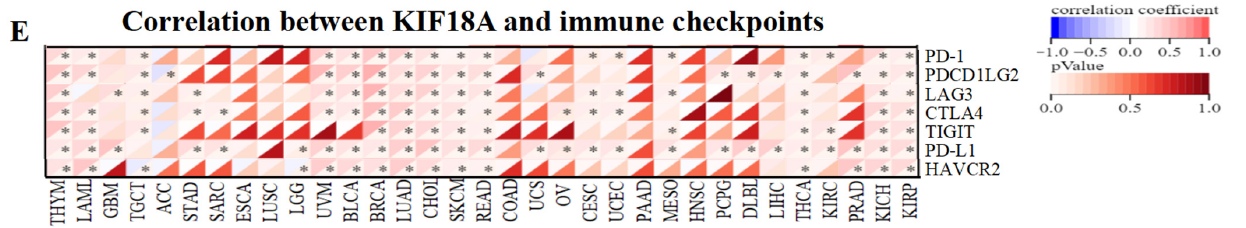
Figure 5. Correlation analysis between KIF18A and immune regulatory genes in pan-cancer. ( A )Correlation between KIF18A and MHC genes. ( B ) Correlation between KIF18A and immunostimulator genes. ( C ) Correlation between KIF18A and chemokines. ( D ) Correlation between KIF18A and chemokines receptors. ( E ) Correlation between KIF18A and immune checkpoints. * p < 0.05.